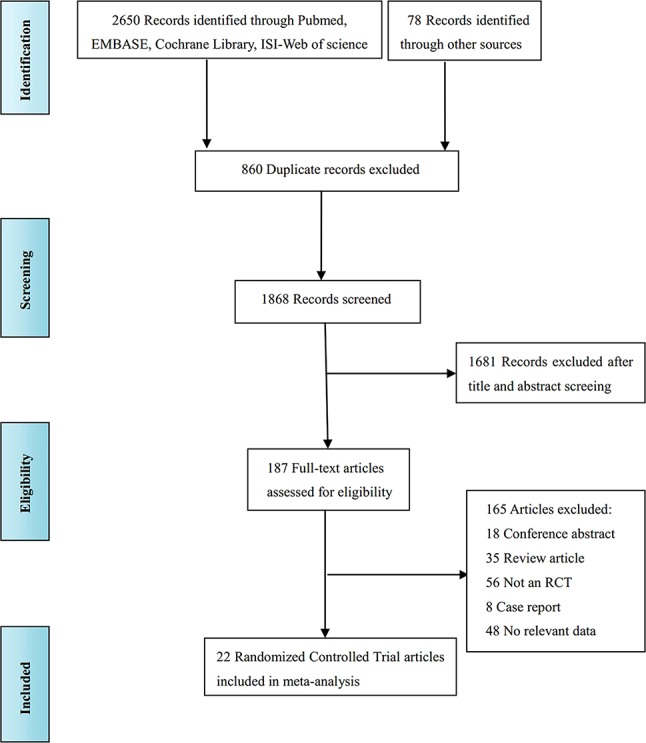
Study flow diagram.